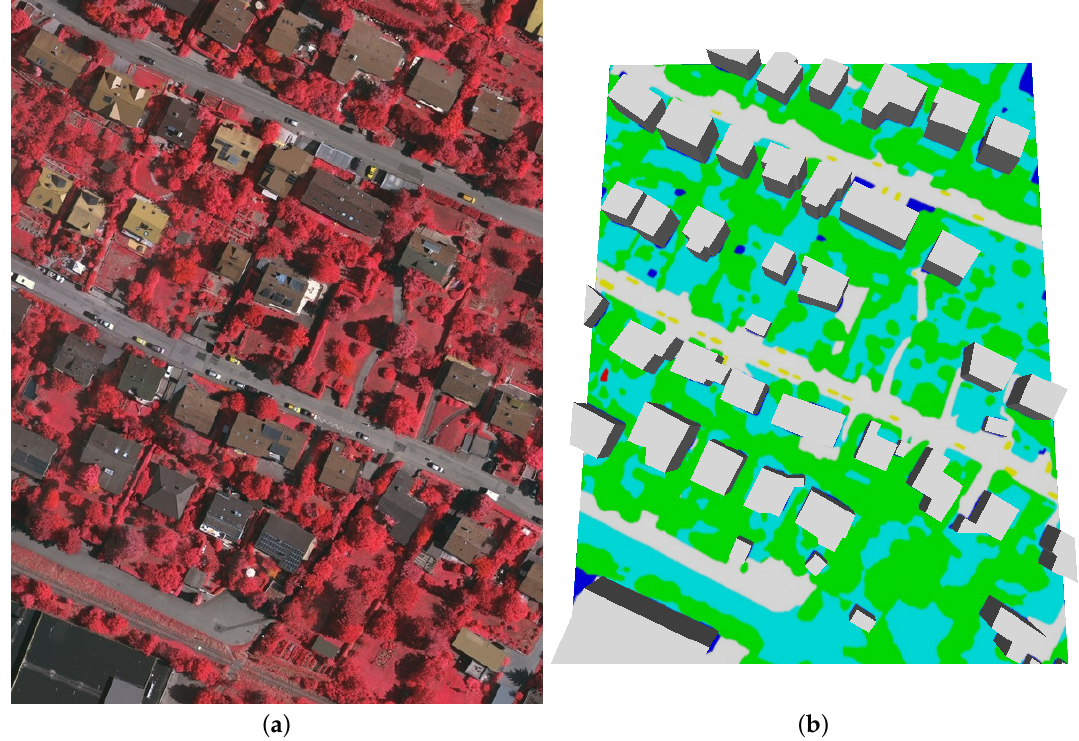
Figure 8. Modeling result on another block. ( a ) The input orthophoto with infra-red channel of another urban area. ( b ) Our generated LOD1 model of the scene overlaid on the